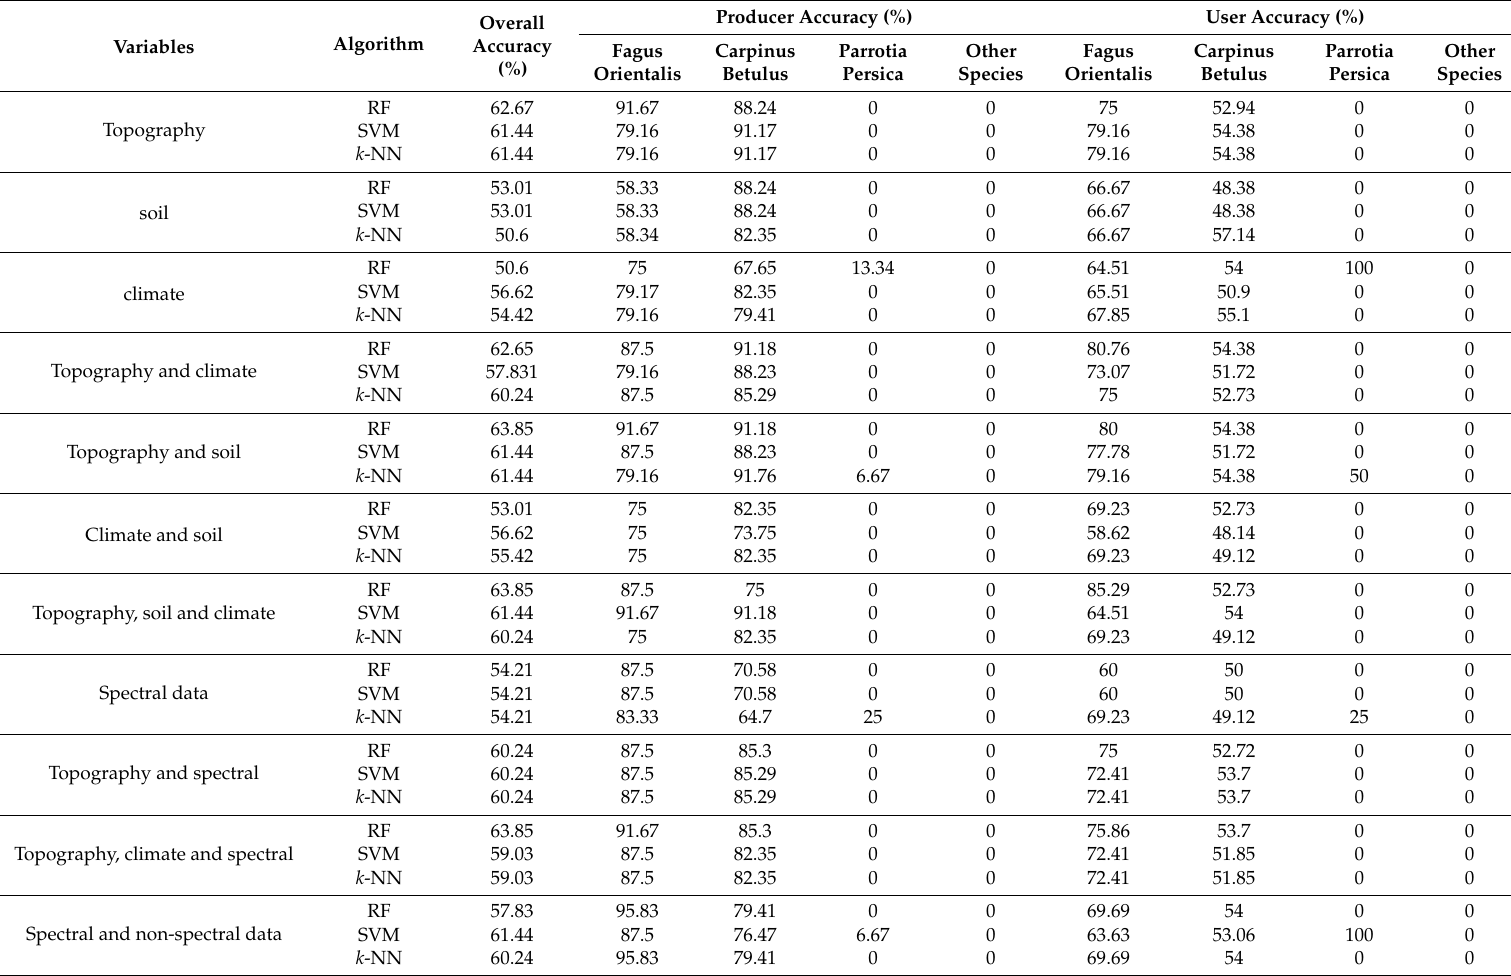
Table 7. The classification accuracy assessment of tree and shrub species groups by using Random forest (RF), support vector machine (SVM) and k -nearest neighbor ( k -NN)